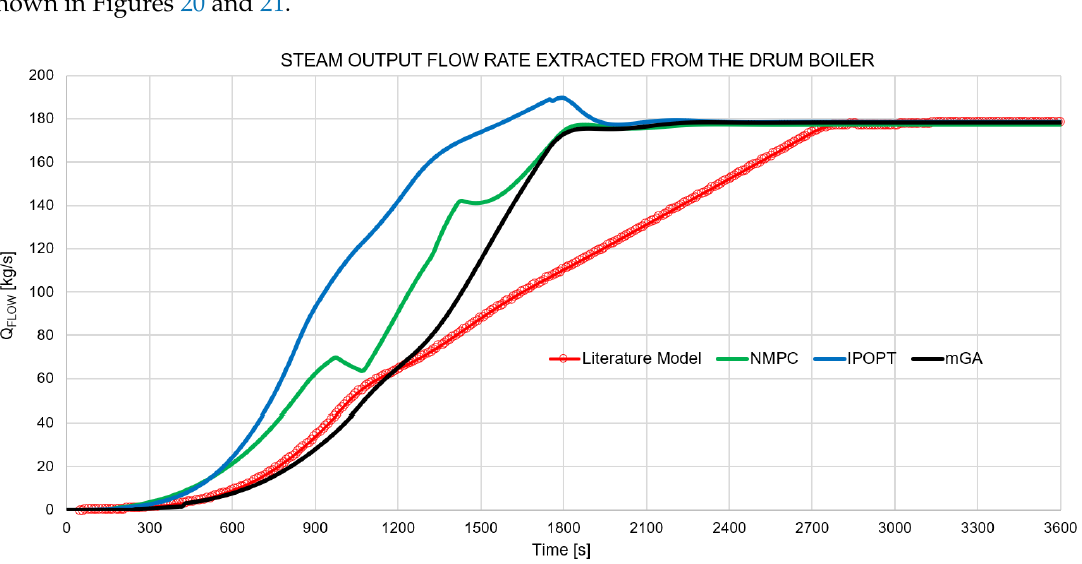
Figure 16. Results comparison between the curves of the operating reference profile available in the literature (red line), the optimized profiles reported by [17] (green line) and [20] (blue line), and the proposed approach (black line) for the output flow rate of the steam that exits from the drum boiler. NMPC, nonlinear model predictive control; IPOPT, interior point optimizer algorithm.